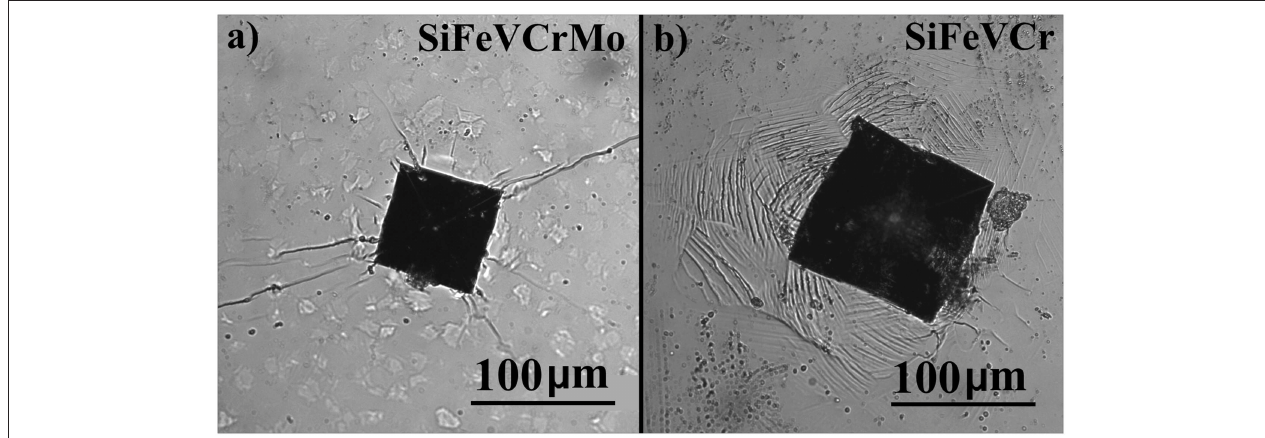
FIGURE 5 | Optical microscope images of indentations following Vickers Hardness testing in the as-cast samples, showing evidence of (a) brittle fracture in SiFeVCrMo and (b) ductile behavior in